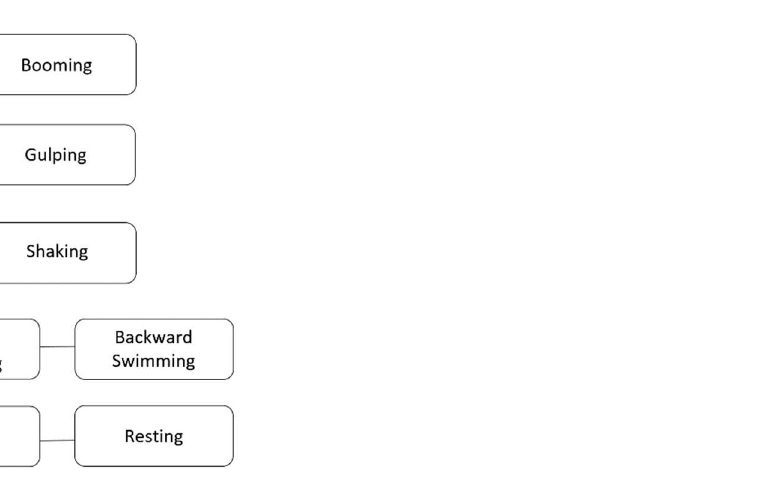
Figure 4. Hierarchy used to label behavioral classes when an animal was performing simultaneous behaviors. For example, if an individual was both forward swimming and booming, those data points would be labeled as